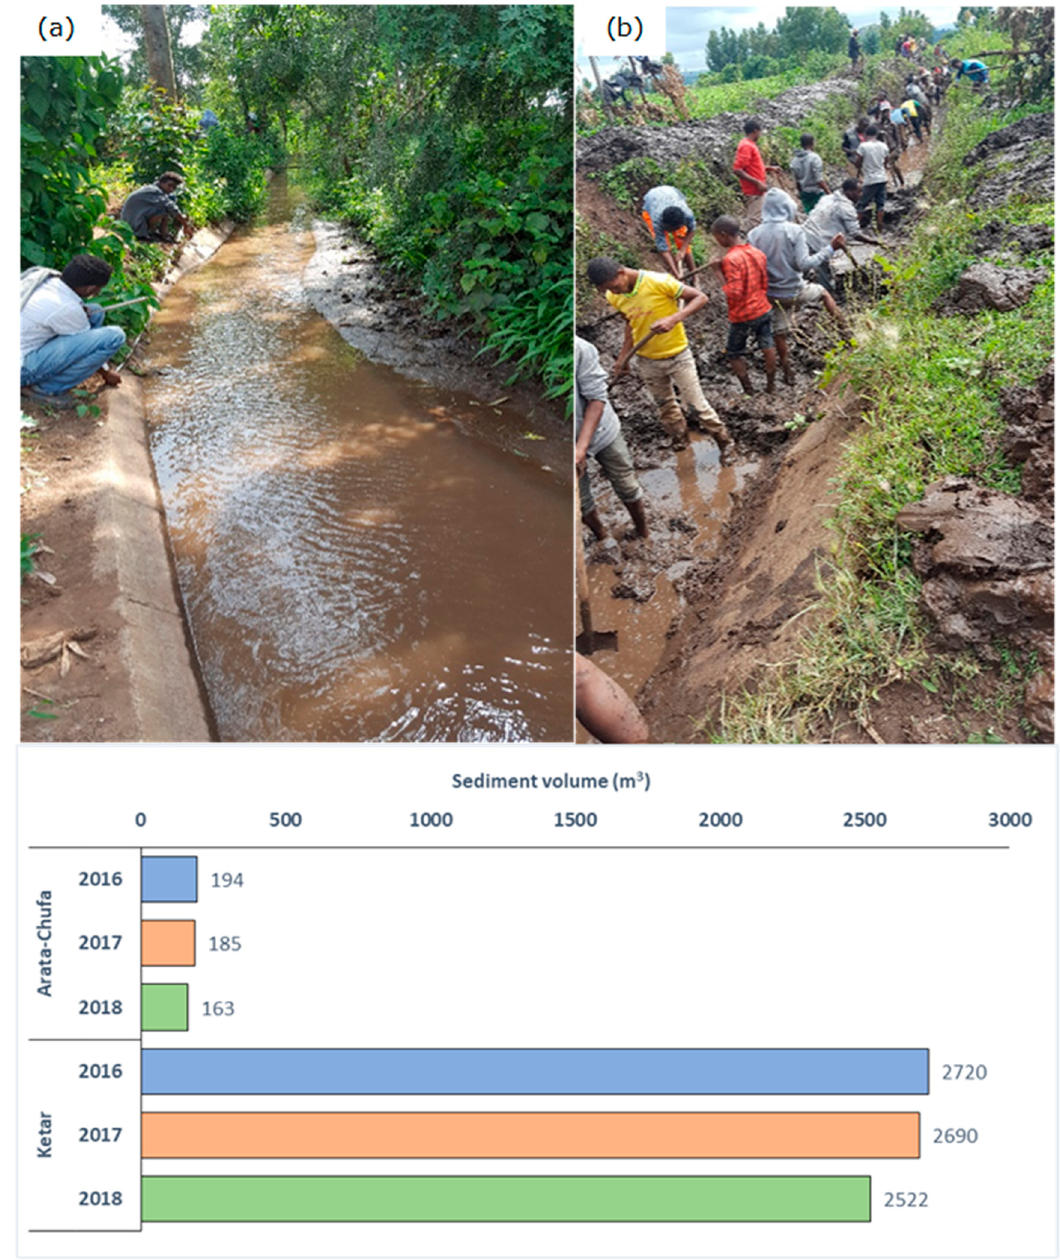
Figure 10. Volume of sediment removed from the main canal of the ( a ) Arata-Chufa and ( b ) Ketar irrigation scheme.